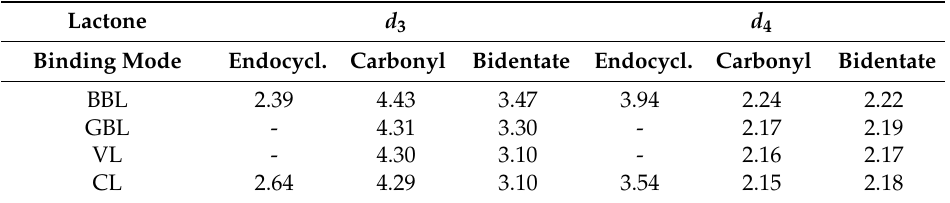
Table 6. Distances between magnesium and relevant oxygen atoms of the coordinated lactones in